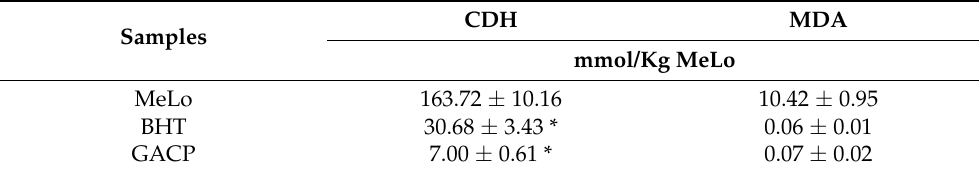
Table 4. Inhibition of lipid oxidation of MeLo by